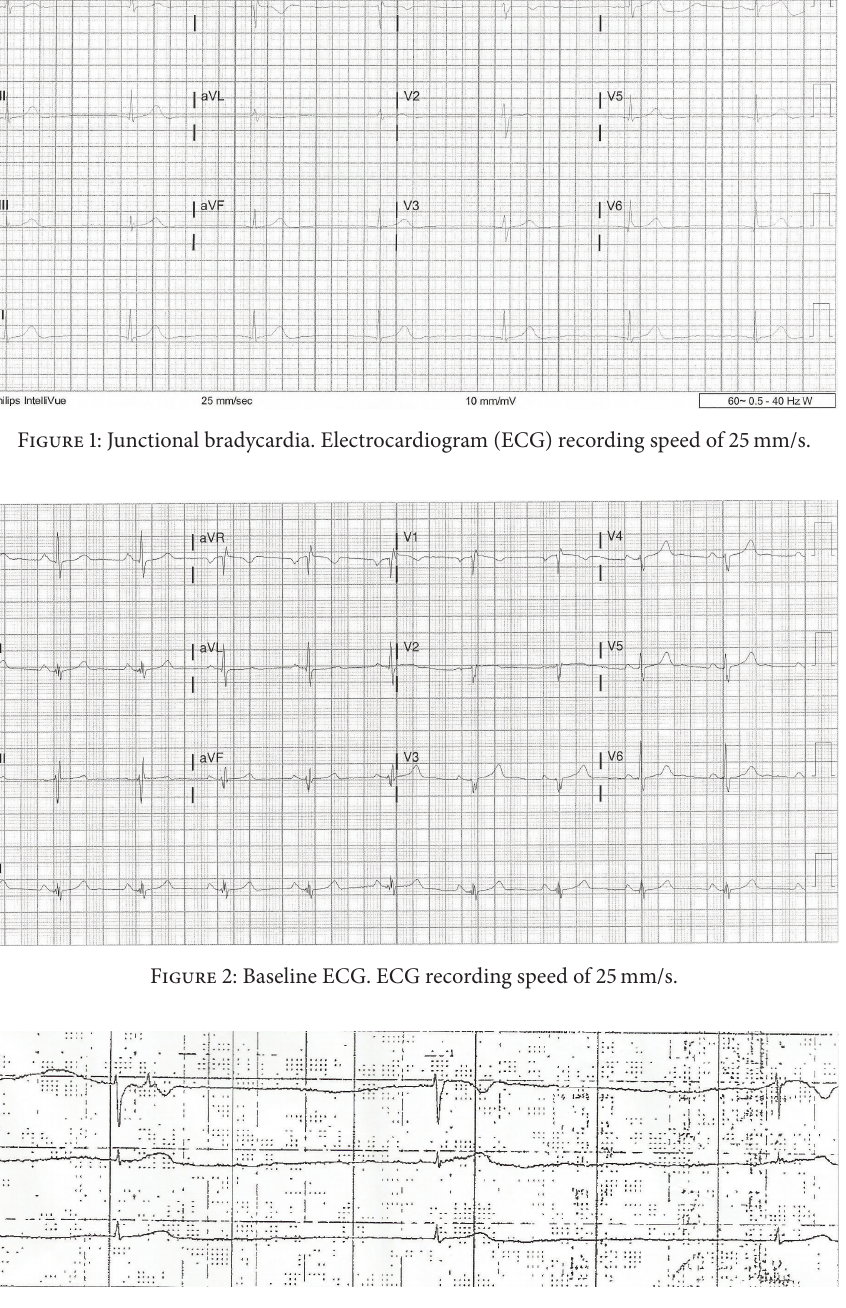
(ROSC) achieved in 2 minutes. Blood pressures at